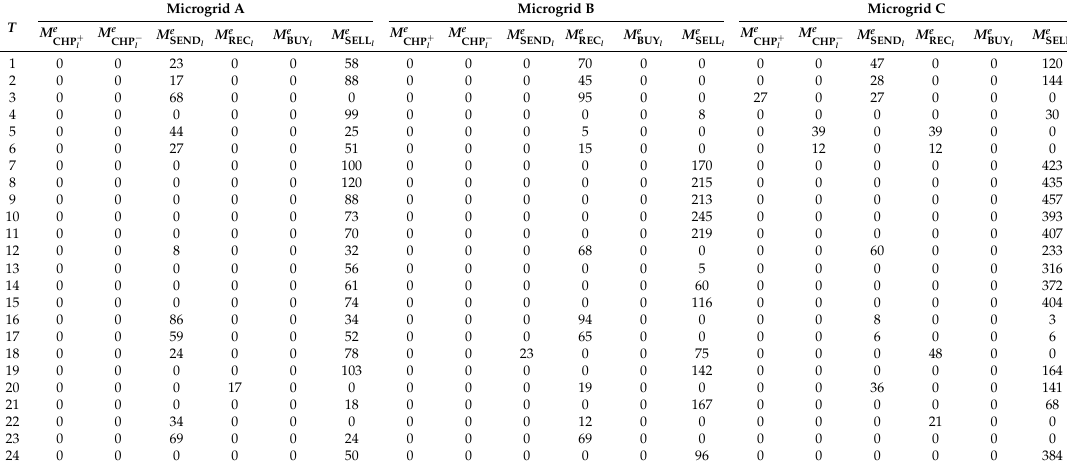
Table 4. Global optimization of electric energy in Step E-2.